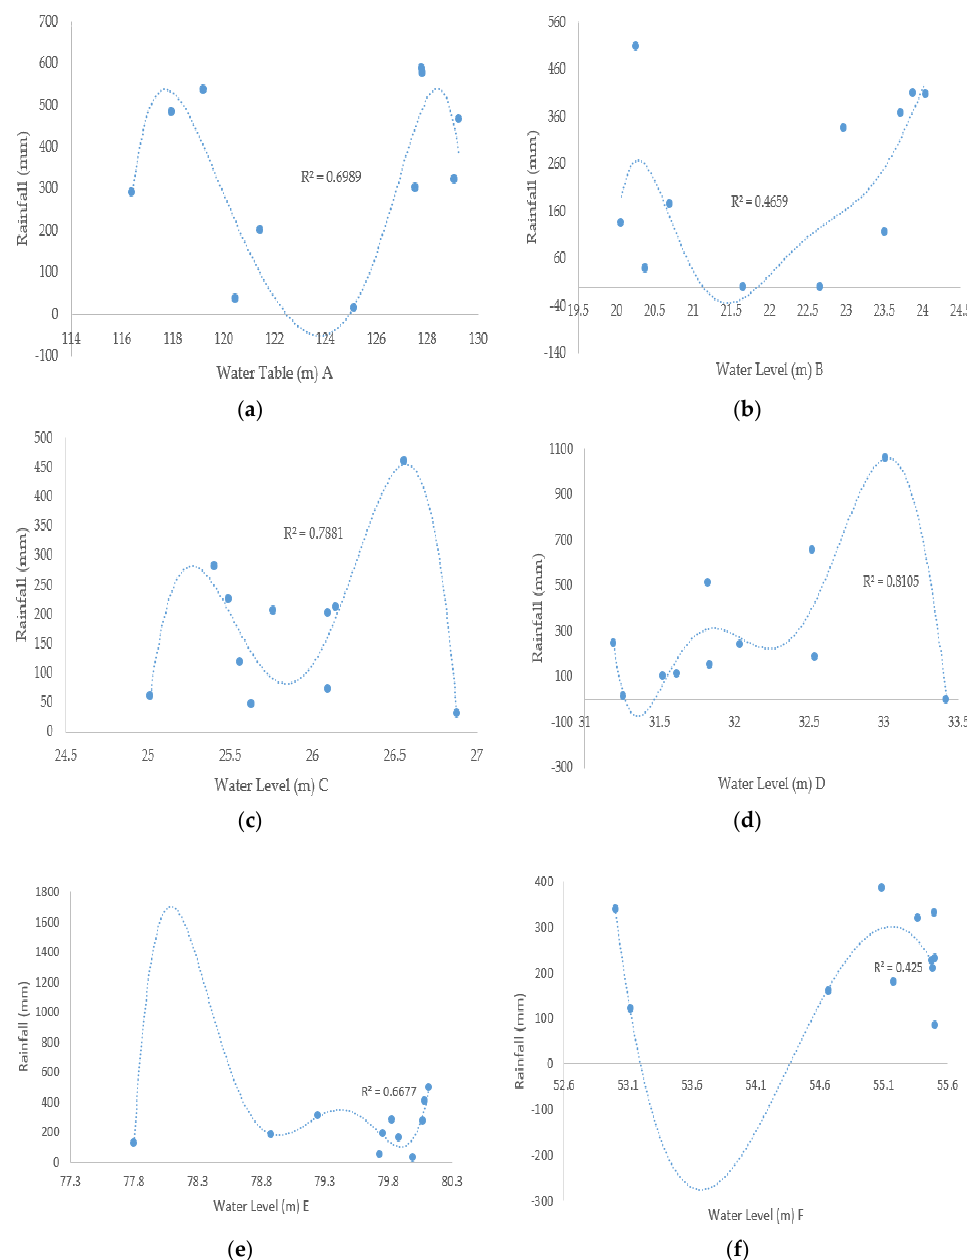
Figure 2. Model summary of polynomial equation analysis for the dependent variable (water level, m) against the independent variable (rainfall, mm) at: ( a ) water dam A; ( b ) water dam B; ( c ) water dam C; ( d ) water dam D; ( e ) water dam E; and ( f ) water dam E. For the risk assessment level of the dams, based on the water level indicators marked by the National Water Guideline from the Water Supply Department, the numbers of days that the water level at each dam categorized as good, alert, or critical are analyzed and tabulated in Table 1 below. From Table 1, the North Borneo of Sabah, Malaysia dams ranked from most at risk to least are as follows: